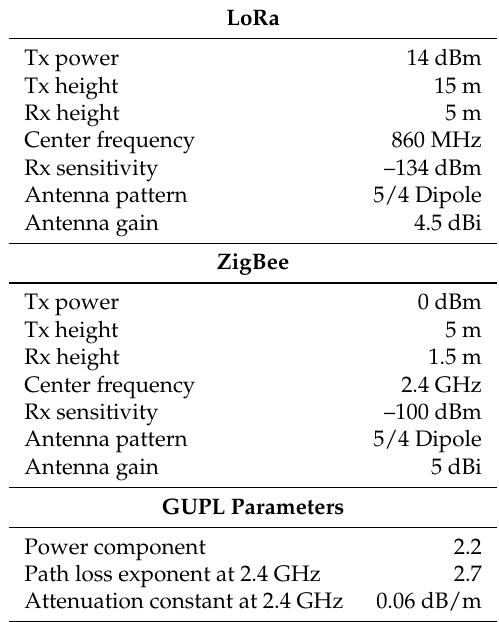
Table 3. Simulation parameters obtained from the developed demonstrator’s